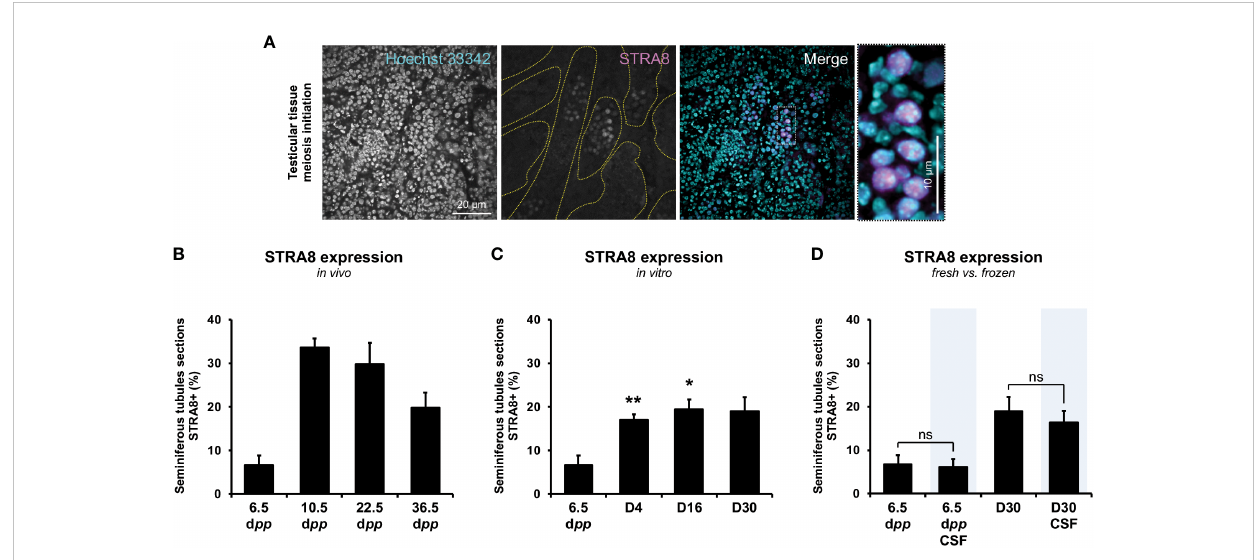
FIGURE 3 Evaluation of the onset of meiosis initiation throughout the fi rst spermatogenic wave. The presence of STRA8 (A) , a protein enabling the initiation of the transition between mitosis and meiosis, was assessed throughout the fi rst spermatogenic wave for in vivo testicular tissues (B) and in vitro testicular explants obtained throughout 30-day-organ culture (C) (n=3×6 fragments per condition ×3 slides ×30 seminiferous tubules) at D4, D16, and D30. Representative data of STRA8 staining is presented. A comparison between fresh and frozen prepubertal testicular explants was assessed at the beginning (6.5 d pp ) and the end (D30 and D30 CSF) of the culture (D) . Testes from mice aged of 6.5, 10.5, 22.5, and 36.5 d pp were used as age- matched corresponding in vivo control (n=3 testis ×3 slides ×30 seminiferous tubules). Seminiferous tubules were delimited with dotted yellow lines. Magni fi cation ×200 (with additional ×5 numerical zoom for micrographs); scale bar: 20 m m (or 10 m m for zoomed micrographs). Kruskal-Wallis tests followed with Dunn ’ s post-test were applied for (A – C) and Mann-Whitney tests was applied for statistical analyses. Data are expressed as mean ± s.e.m. * P <0.05; ** P <0.01. CSF, controlled slow freezing; d pp , days postpartum ; ns, not signi fi cant; STRA8, stimulated by retinoic acid gene